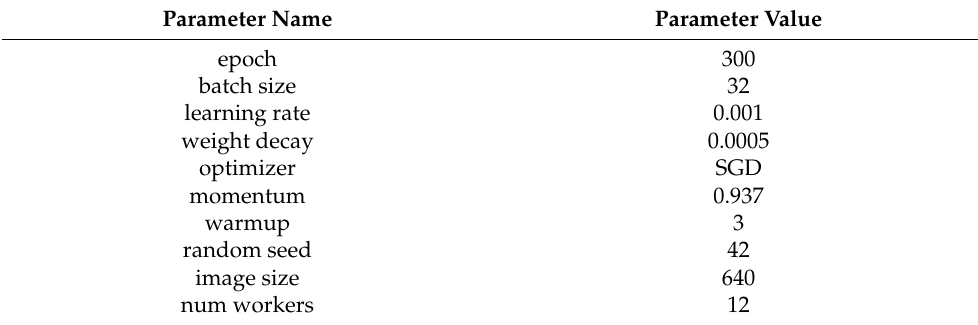
Table 1. The main parameters of the model training process and their corresponding